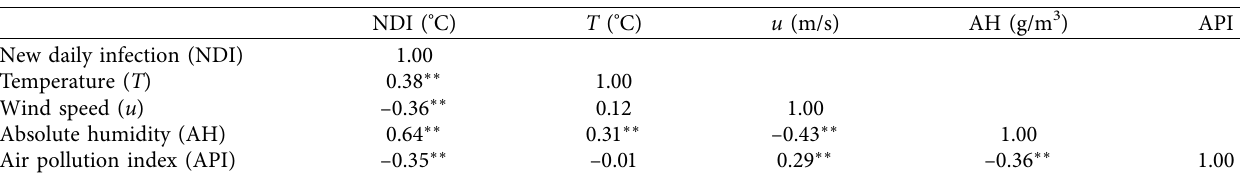
Table 2: Summary of Spearman’s rank correlation test on the association of new daily COVID-19 cases and weather parameters in